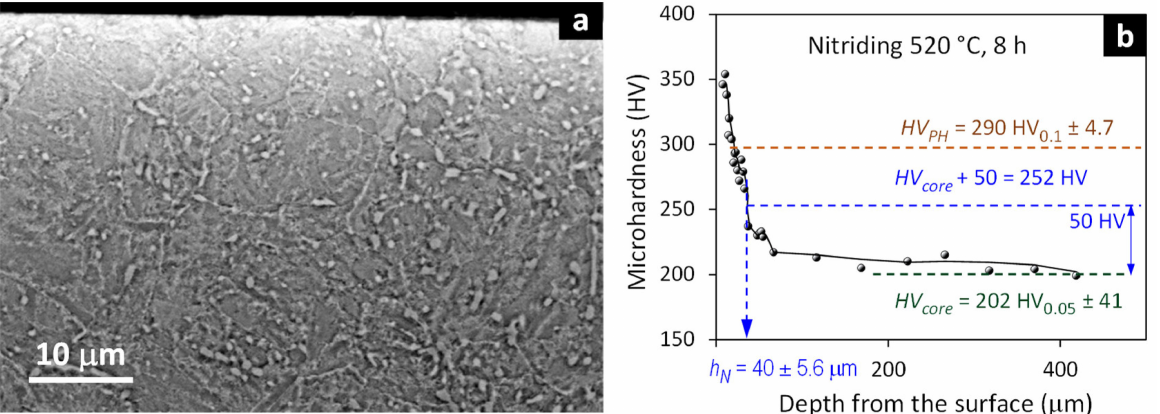
Figure 2. SEM image of the cross section of the nitrided surface layer in the quenched and highly tempered (secondary-hardened) substrate ( a ); defining the nitrided layer depth ( h N ) based on the hardness profile ( b